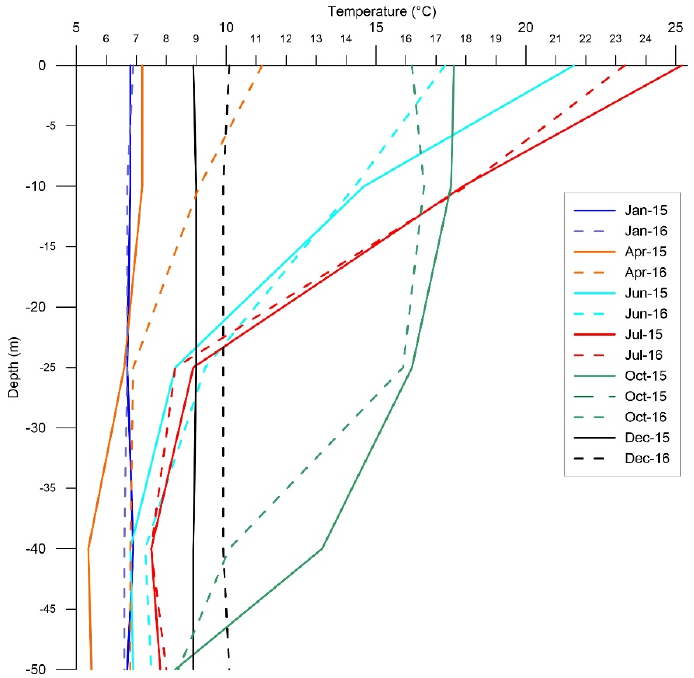
Figure 5. Reservoir temperatures along the water column.